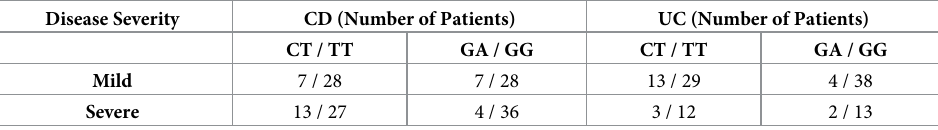
Table 2. The number of CD and UC patients within different disease severity condition and PTPN variants. Disease